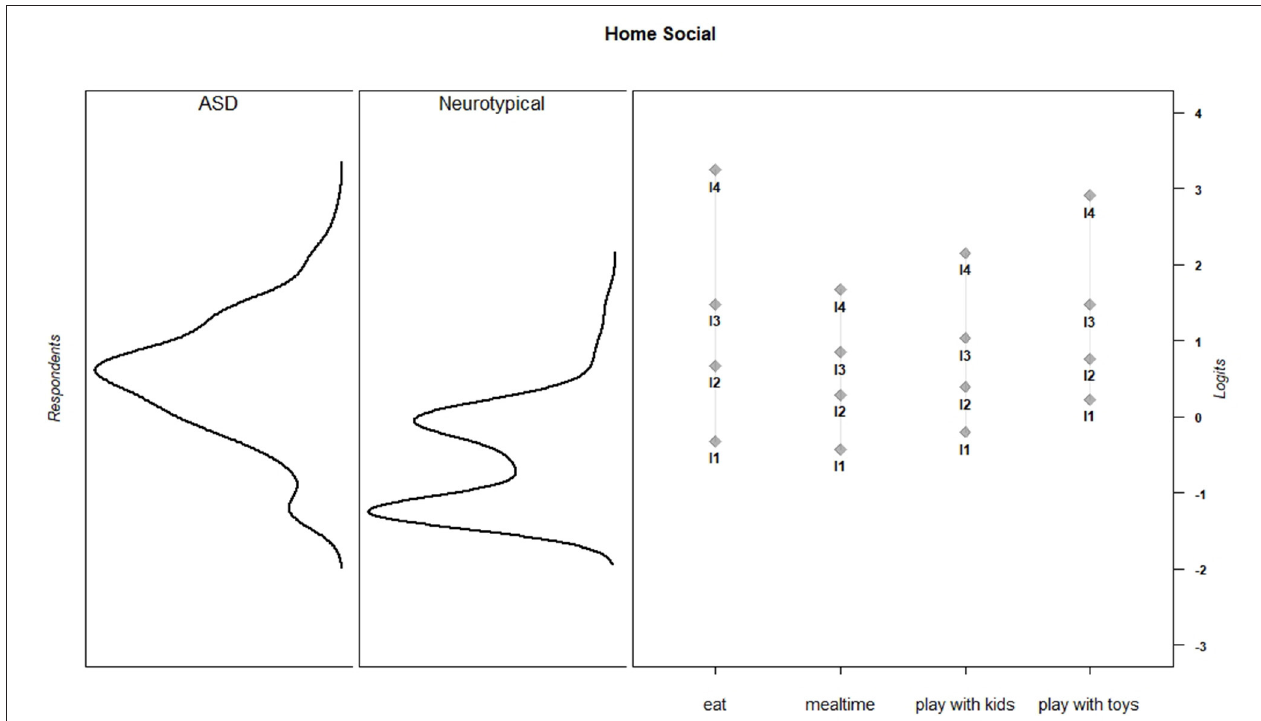
FIGURE 3 | Home social item parameters and person parameters by